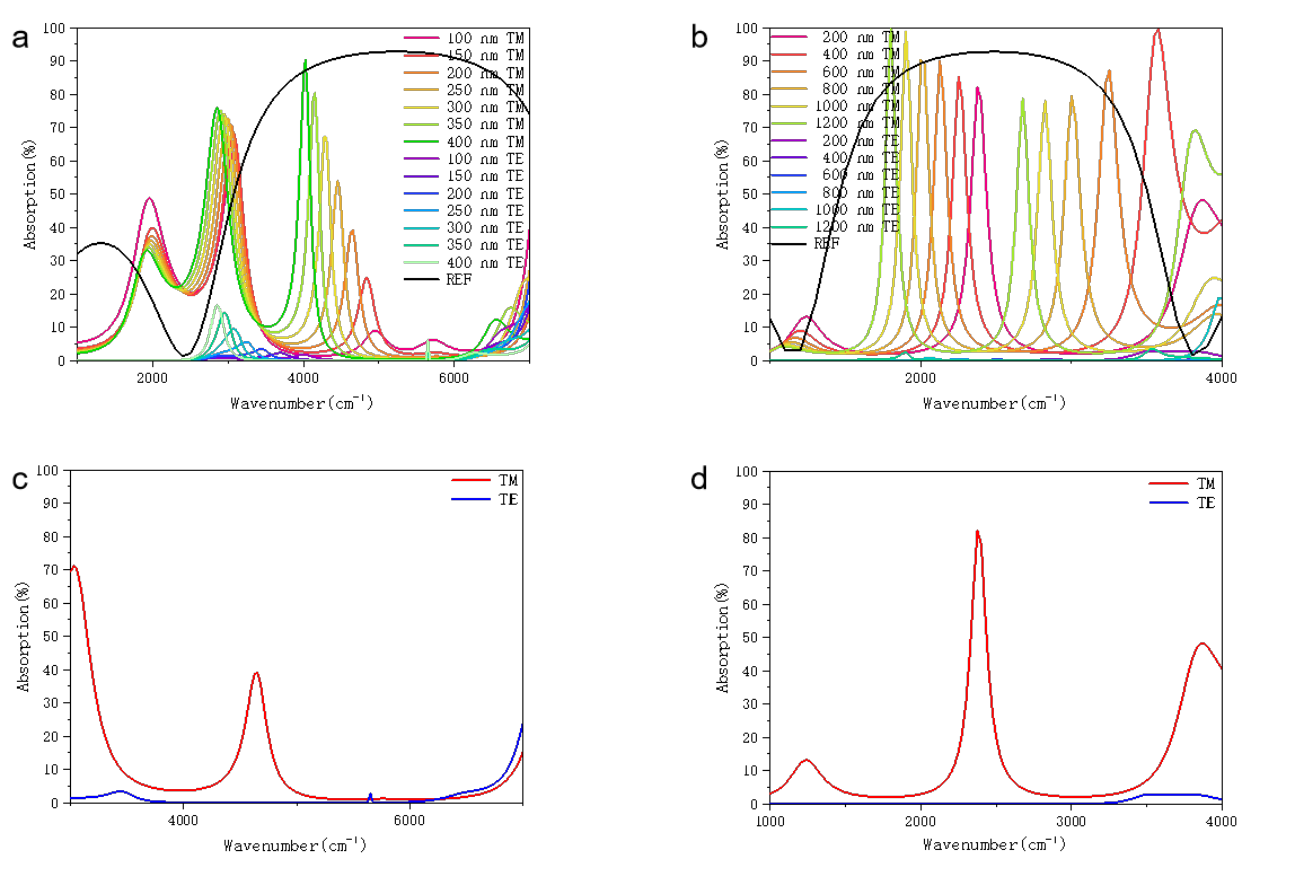
Figure 4. ( a ) TM wave and TE wave absorption curves with different resonant cavity thickness and the reflection window of Bragg mirror in short-wave region. ( b ) TM wave and TE wave absorption curves with different resonant cavity thickness and the reflection window of Bragg mirror in mid- wave region. ( c ) Single peak of TM and TE in short-wave region. ( d ) Single peak of TM and TE in mid-wave region.